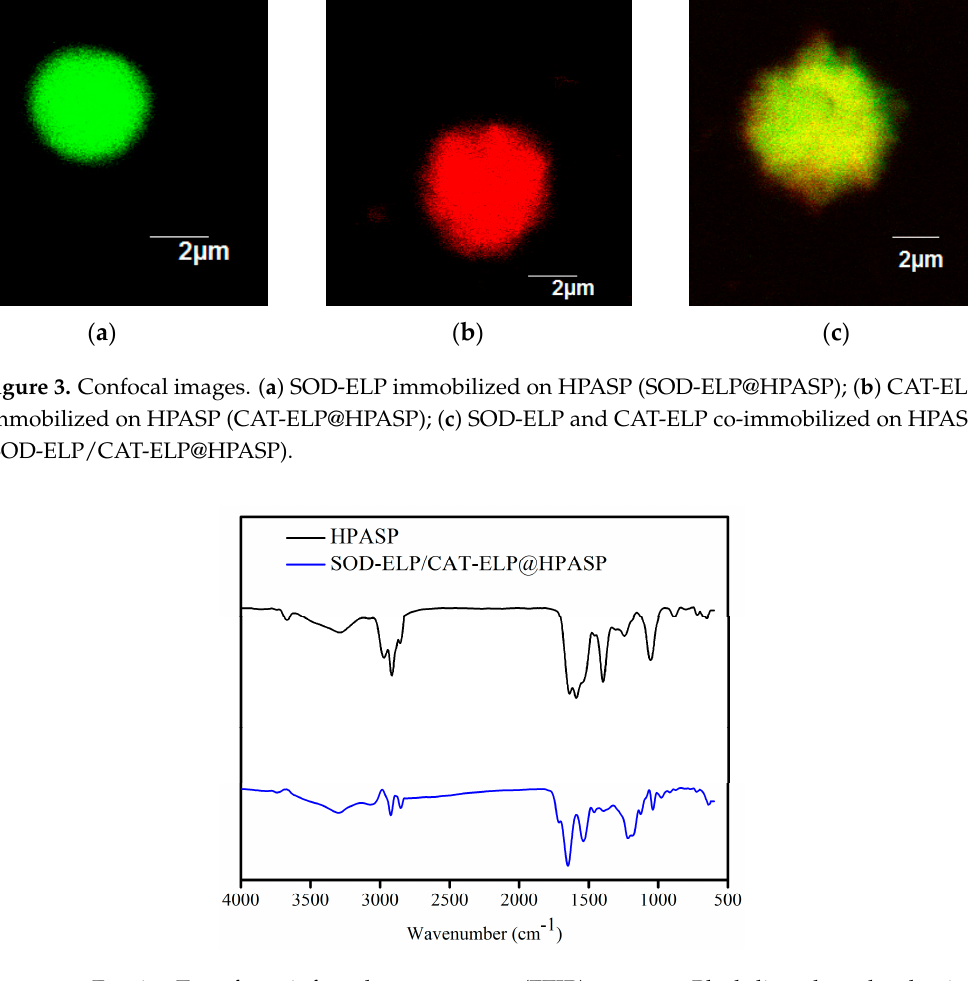
Figure 4. Fourier Transform infrared spectroscopy (FTIR) spectra. Black line: hexadecylamine ‐ modified polyaspartic acid (HPASP); Blue line: SOD ‐ ELP and CAT ‐ ELP co ‐ immobilized on HPASP (SOD ‐ ELP/CAT ‐ ELP@HPASP).